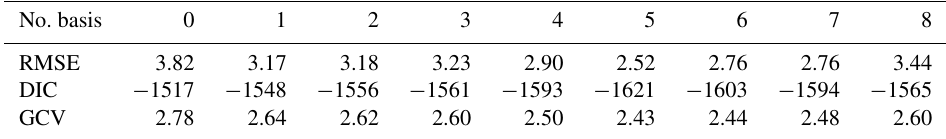
Table A1. Summary of results from fitting nine candidate statistical models (annual average over